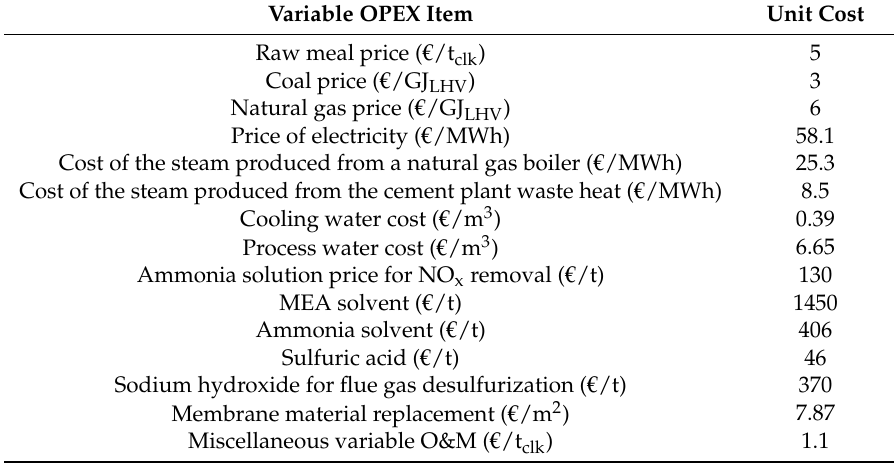
Table 4. Unit cost of materials and utilities used in the cost analysis.